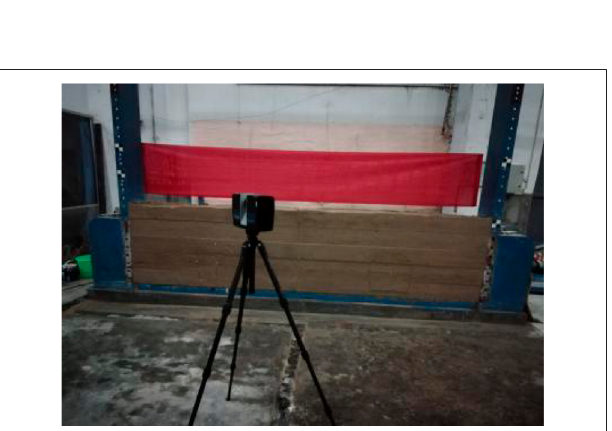
FIGURE 5 | 3D laser